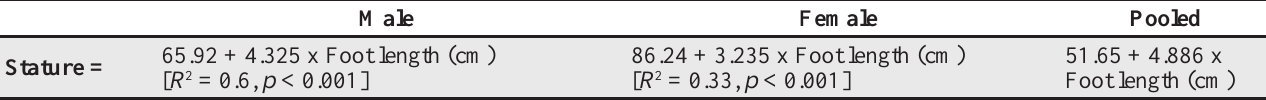
Table 2 : Regression equations for estimation of stature from foot length